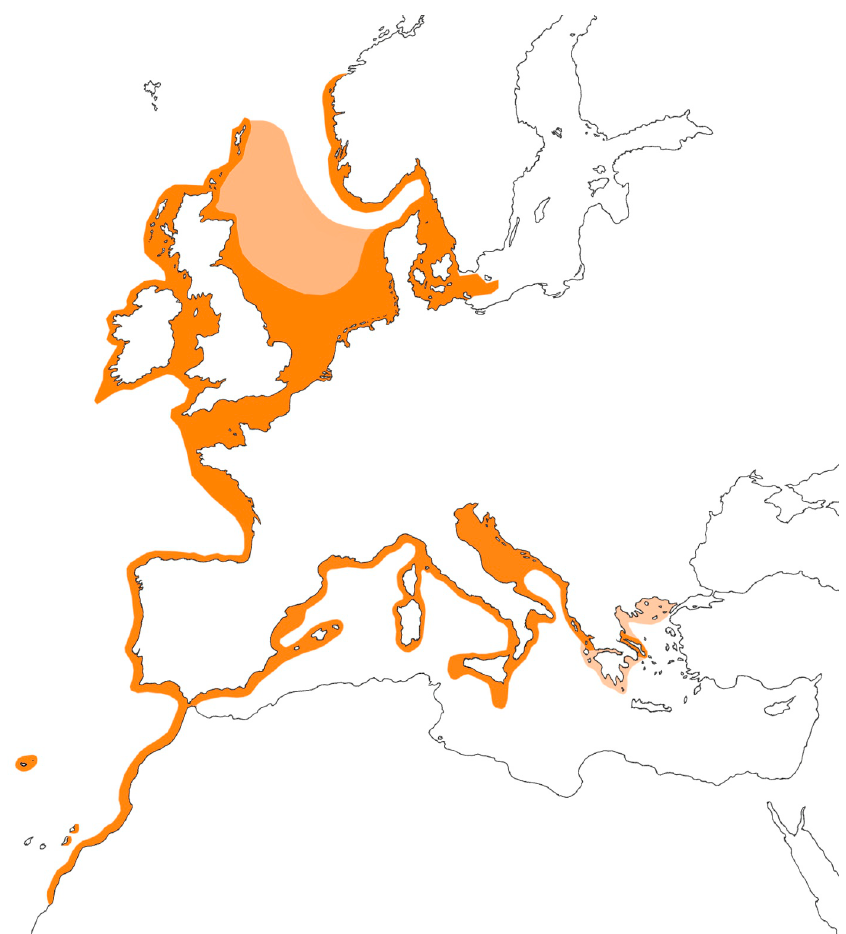
Figure 9. Present geographic distribution of Trisopterus luscus . Lighter orange in the North Sea means lesser abundance. Very light orange around Greece: probable distribution, but not yet proven.